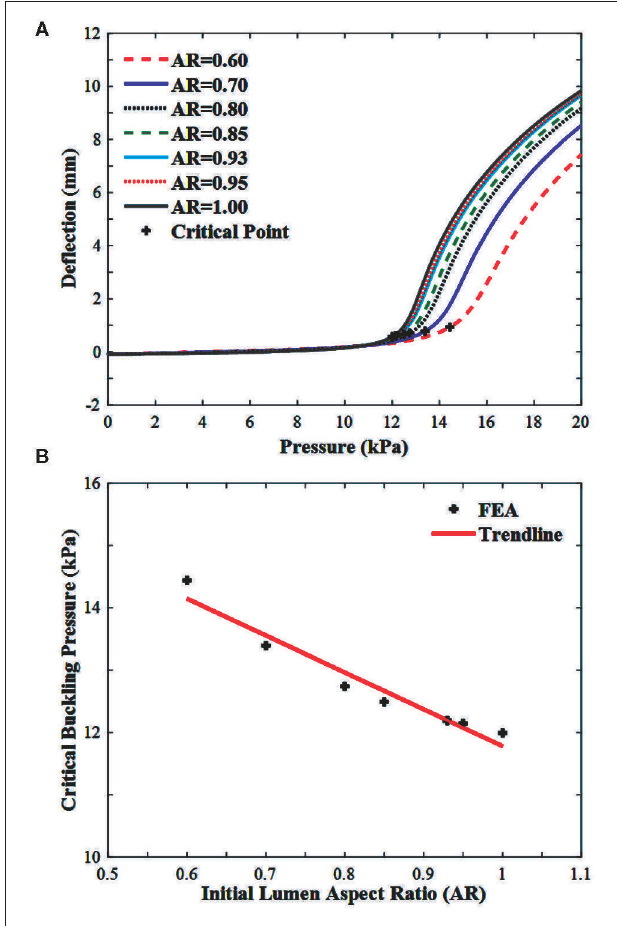
FIGURE 6 | Buckling of arteries with concentric elliptical cross sections. (A) Deflections plotted as functions of lumen pressure. The critical buckling points are marked by “ + ”. (B) Critical buckling pressure plotted as a function of lumen aspect ratio in the range of